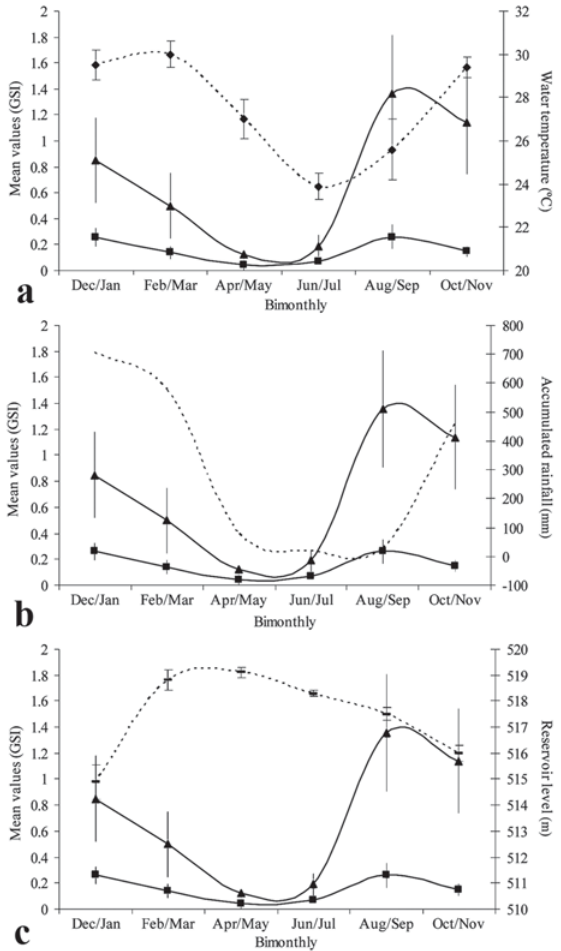
Fig. 2. Male and female gonadosomatic index (GSI) ± SD of Cichla piquiti and environmental variables ± SD collected at the Itumbiara Reservoir between December 2004 and November 2005 [GSI male (square), GSI female (triangle); (a) water temperature, (b) accumulated rainfall, (c) reservoir level].